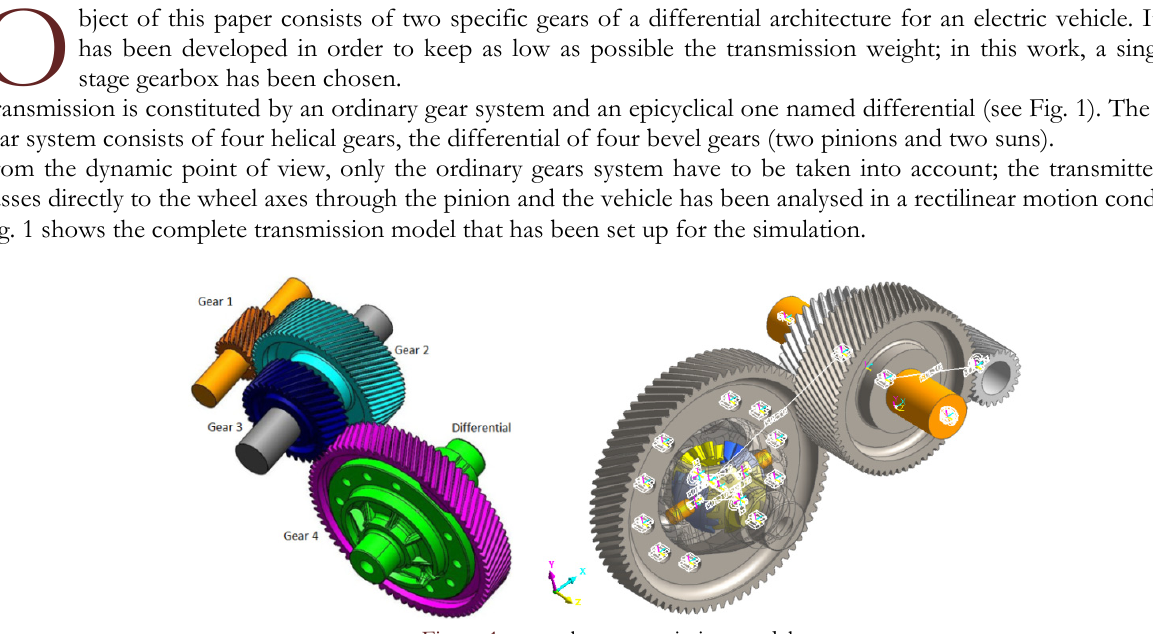
Figure 1: complete transmission